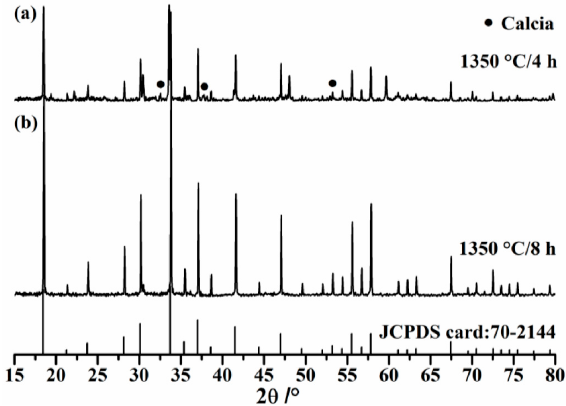
Figure 1. XRD spectra of synthesized C 12 A 7 .